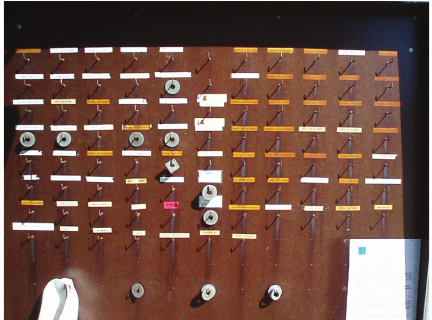
Figure 1: The old manual access monitoring